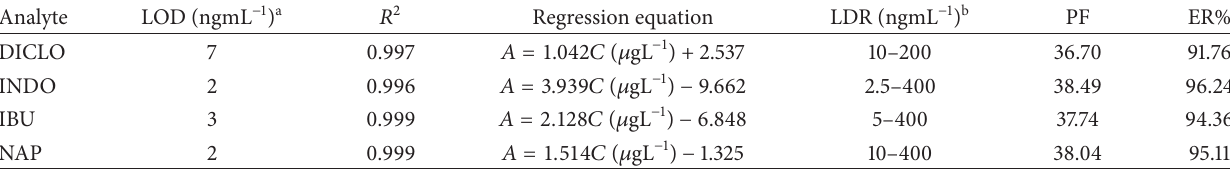
a Limit of detection. b Linear dynamic range. Analyte